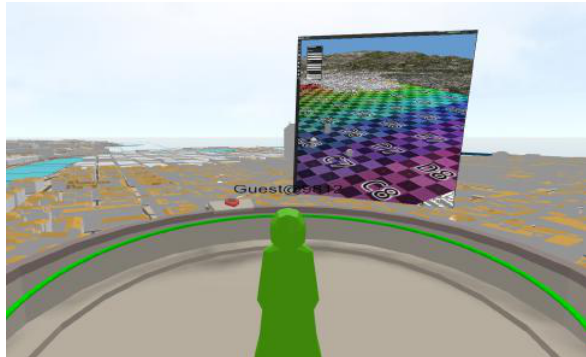
Figure 8. An example of the use of the 3D geo-web renderer in ”Flying campus”, a virtual gathering place. The user can still observe the 3D scene while the integrated multimedia is shown to the